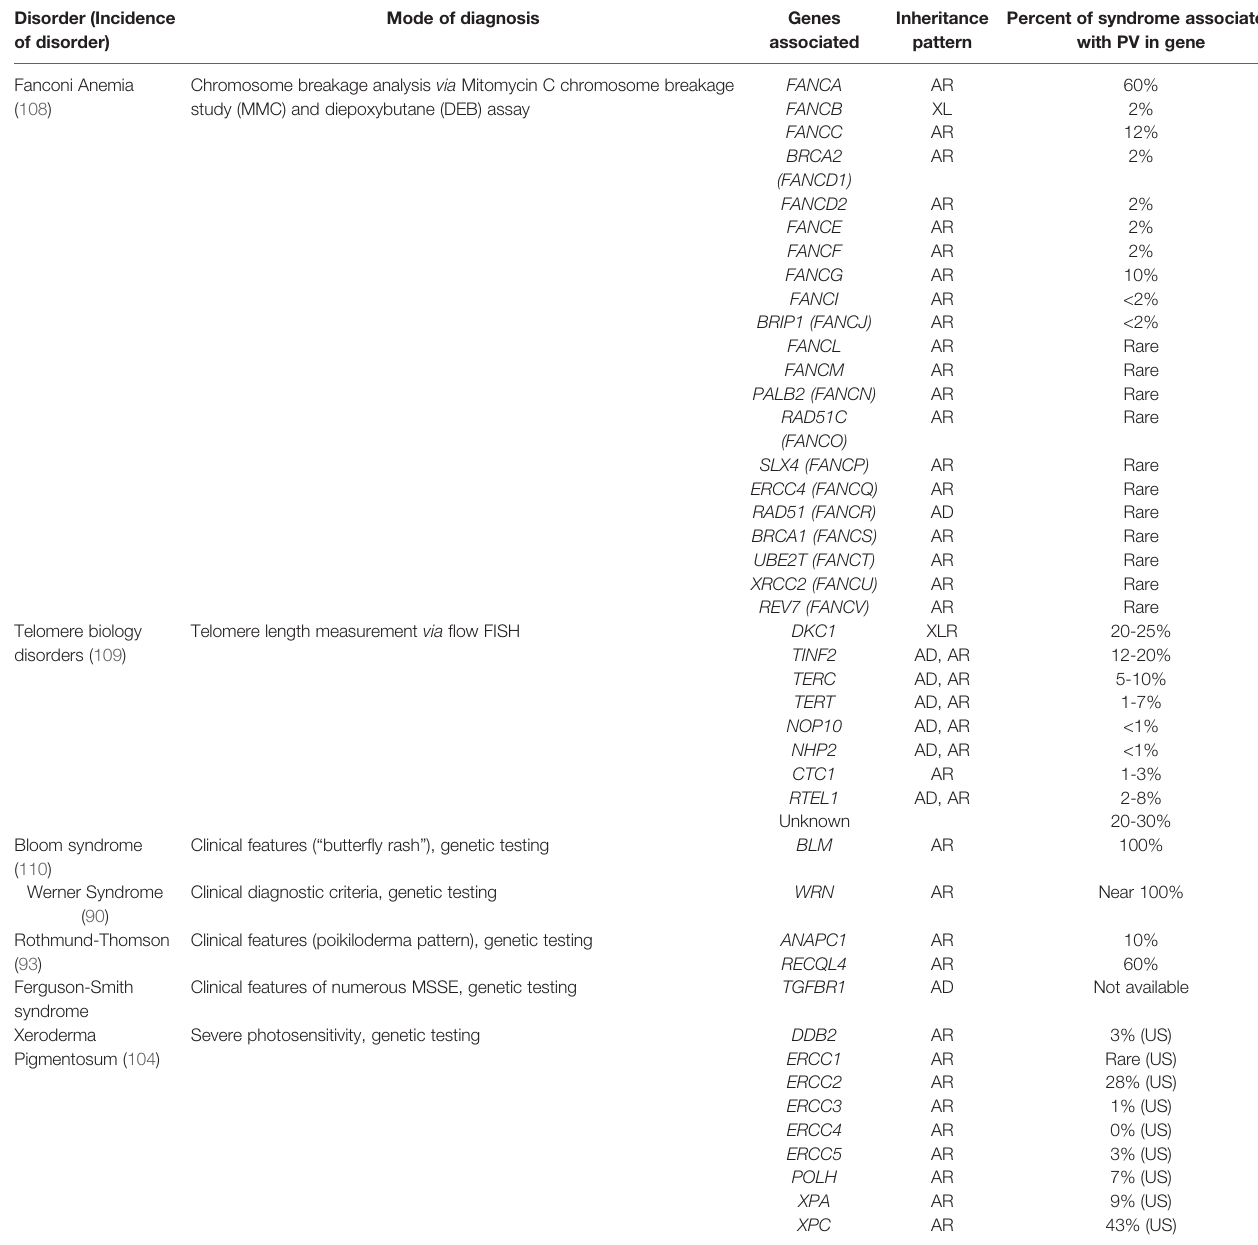
TABLE 1 | Characteristics of Cancer Predisposition Syndromes Associated with Non-Melanoma Skin